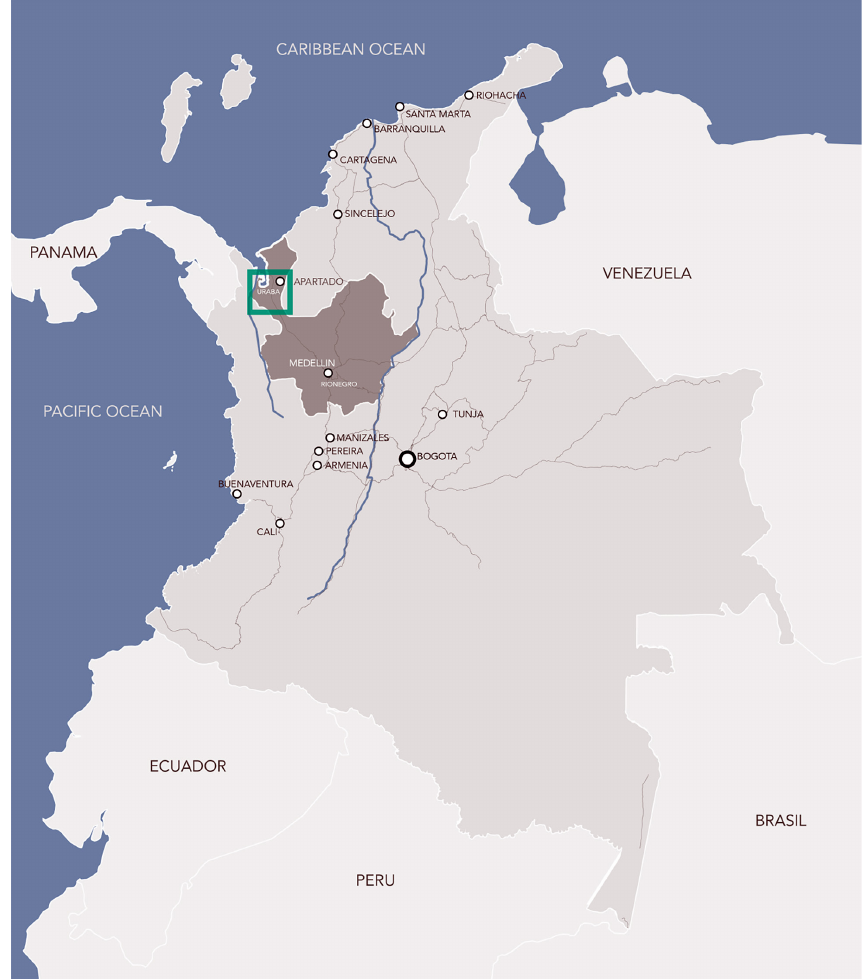
Fig. 1. Location of the region of Urabá in Colombia. Source: own